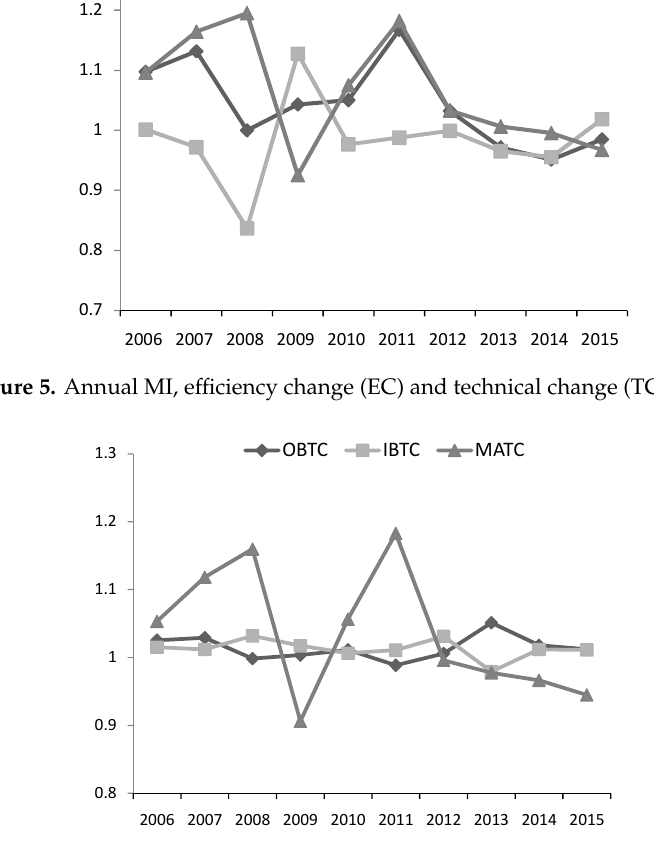
Figure 6. Annual biased technical change index.